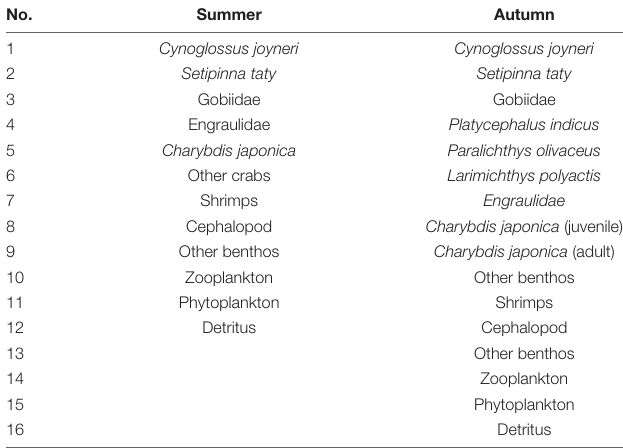
default value is 0.5. All biomass is unified at the wet weight (t · km − 2 ).